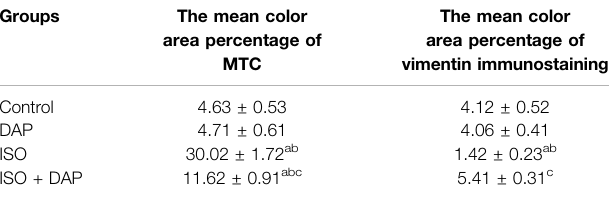
TABLE 4 | The mean color area percentage of MTC and vimentin staining in rats.